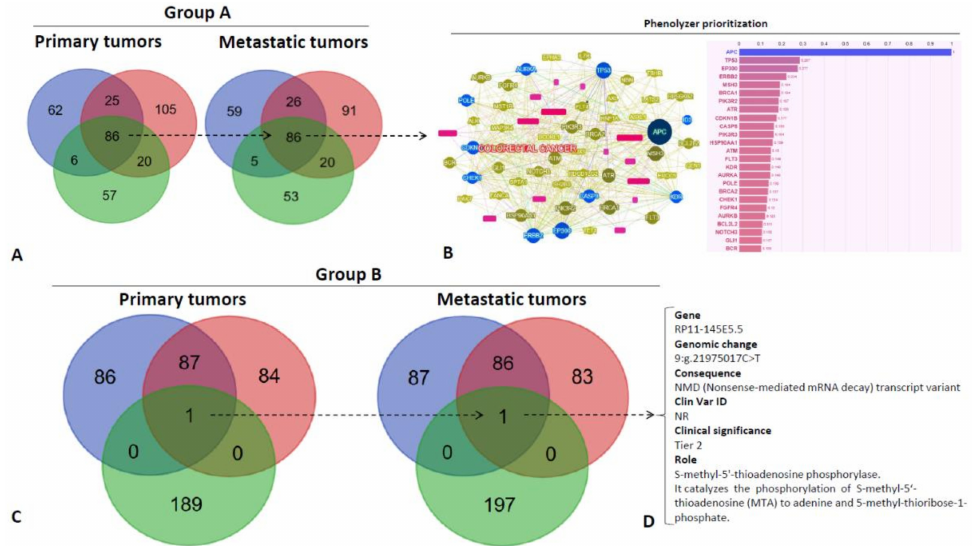
Figure 3. Venn Diagrams of variants shared by primary tumors and metastatic tumors according to group A ( A ) (PAT1, 2 and 3) and group B patients ( C ) (PAT4, 5 and 6). The circles blue refer to genes’ mutations’ of PAT1, the circle red of PAT2 and the circle green of PAT3. Phenolyzer genetic variants prioritization according to genes shared in group A patients (see Methods) ( B ). Only one gene (indicated by the discontinuous arrow is shared in group B and it is emphasized in on the right side ( D ).